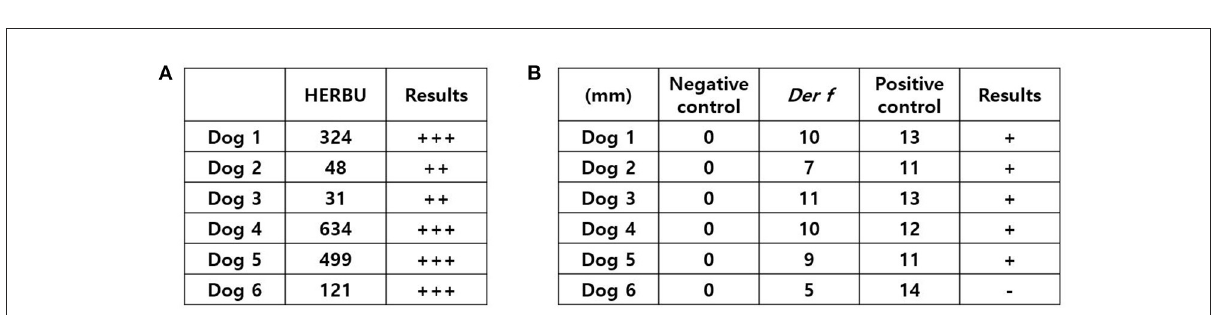
FIGURE3 Verification of Der f sensitization. (A) Results of the Der f -specific IgE assay. (B) Results of the intradermal test. Dog 6 showed a wheal at the Der f injection site, which was not larger than half of that of a wheal at the histamine injection site; hence, it was evaluated as negative. HERBU, Heska Epsilon Receptor Binding Units; Der f , Dermatophagoides farinae